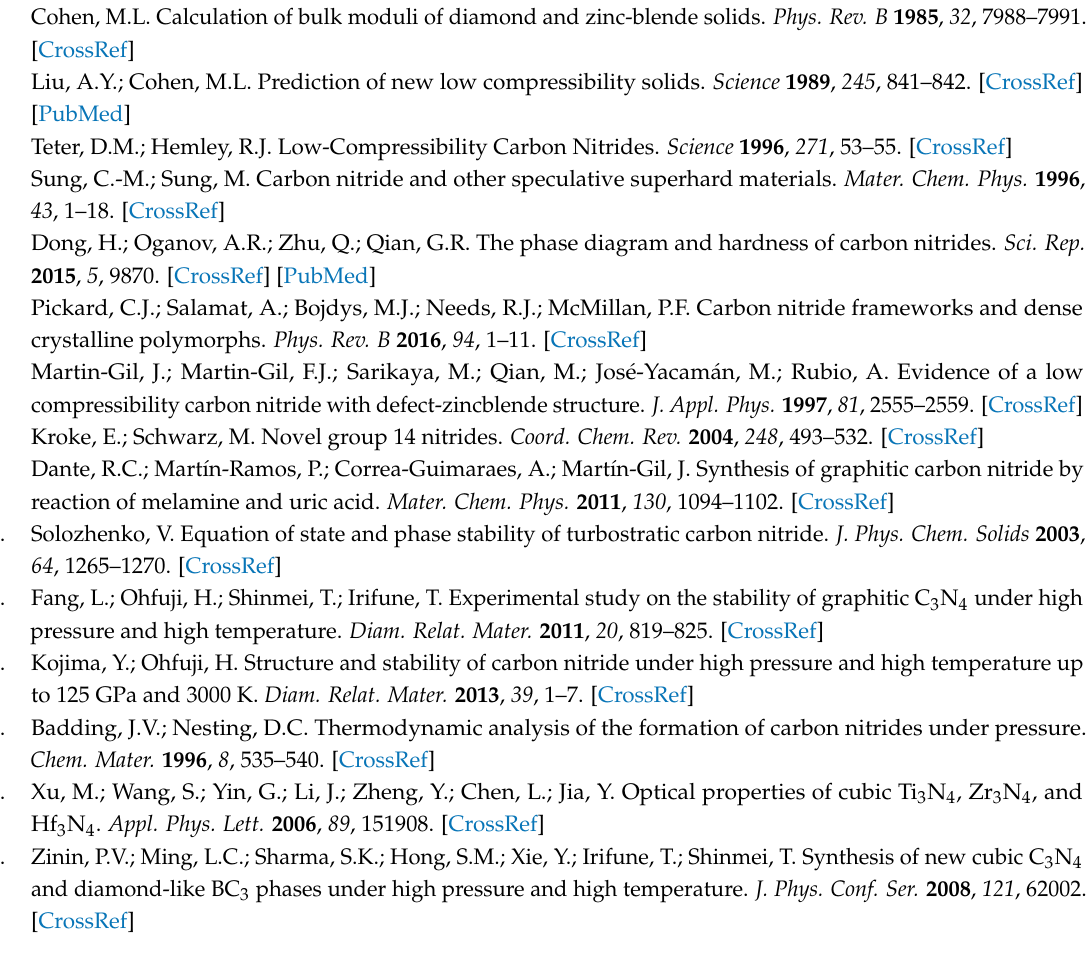
Table S1: X-ray diffraction data of melamine; Table S2: X-ray diffraction data of melam cal.; Figure S1: Raman spectra of melam and the samples treated at 5 GPa and 400, 500, 600, and 700 ◦ C at laser radiations of 325, 532, and 633 nm; Figure S2. FTIR spectrum of the sample treated at 5 GPa and 700 ◦ C; Table S3: Elemental analysis of melam (cal. and exp.) and the samples treated at 5 GPa and different temperatures (400, 500, 600, and 700 ◦ C). Acknowledgments: This work was supported by National Natural Science Foundation of China (NSFC) (51722209, 51332005, 51525205), Project funded by China Postdoctoral Science Foundation (2017M620097) and 100 Talents Plan of Hebei Province